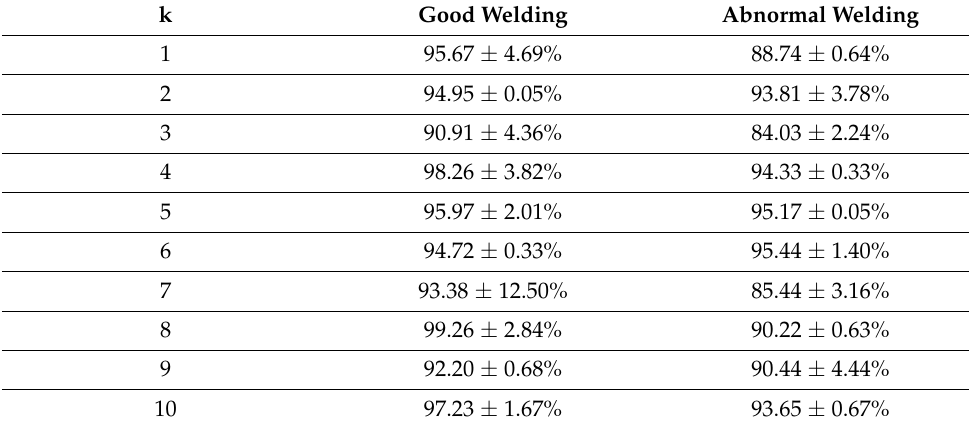
Figure 10. Learning curves for 10 performances using the CNN. Table 2. Performance of the fully connected deep neural network.